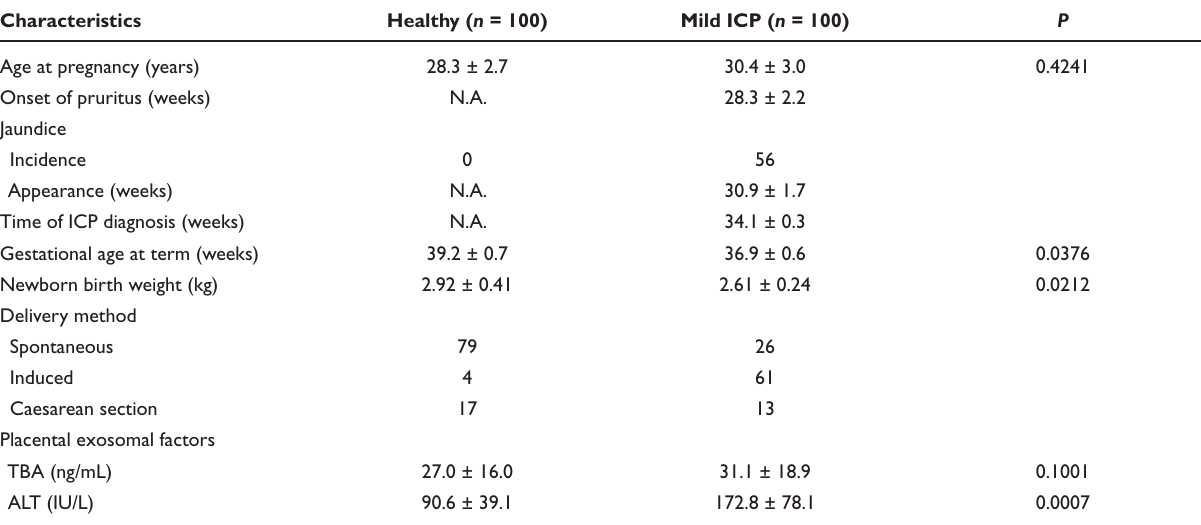
Table 1 . Clinical and placental exosomal characteristics in healthy pregnant women and patients with ICP Characteristics